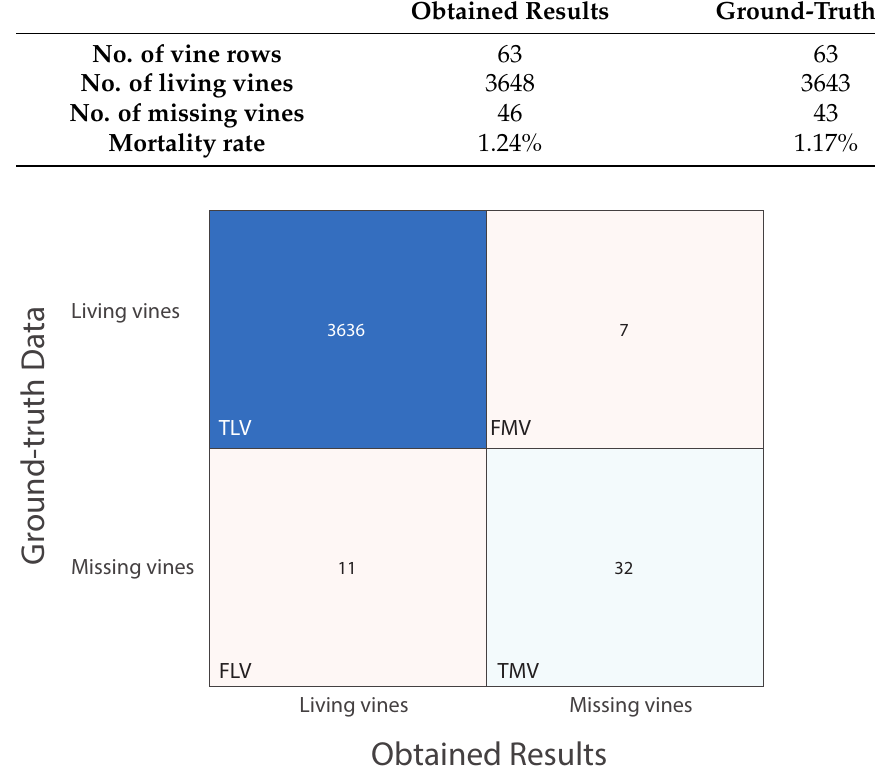
Figure 16. Matching matrix. Assessing the proposed method with Parcel 59B’s ground-truth data.